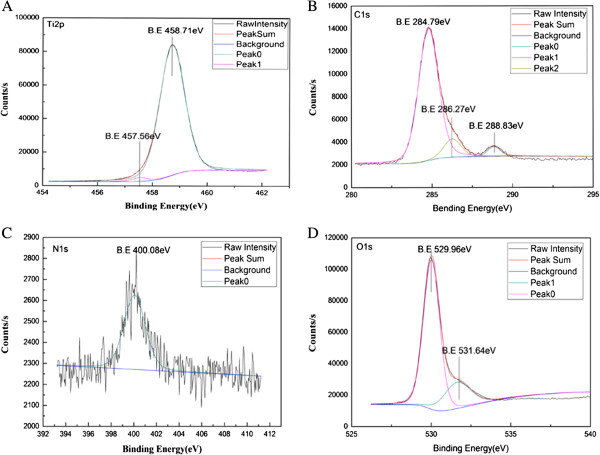
XPS results of composite fiber heat-treated at 550°C then preserved heating in NH3. (A) Ti2p, (B) C1s, (C) N1s,, and (D) O1s.